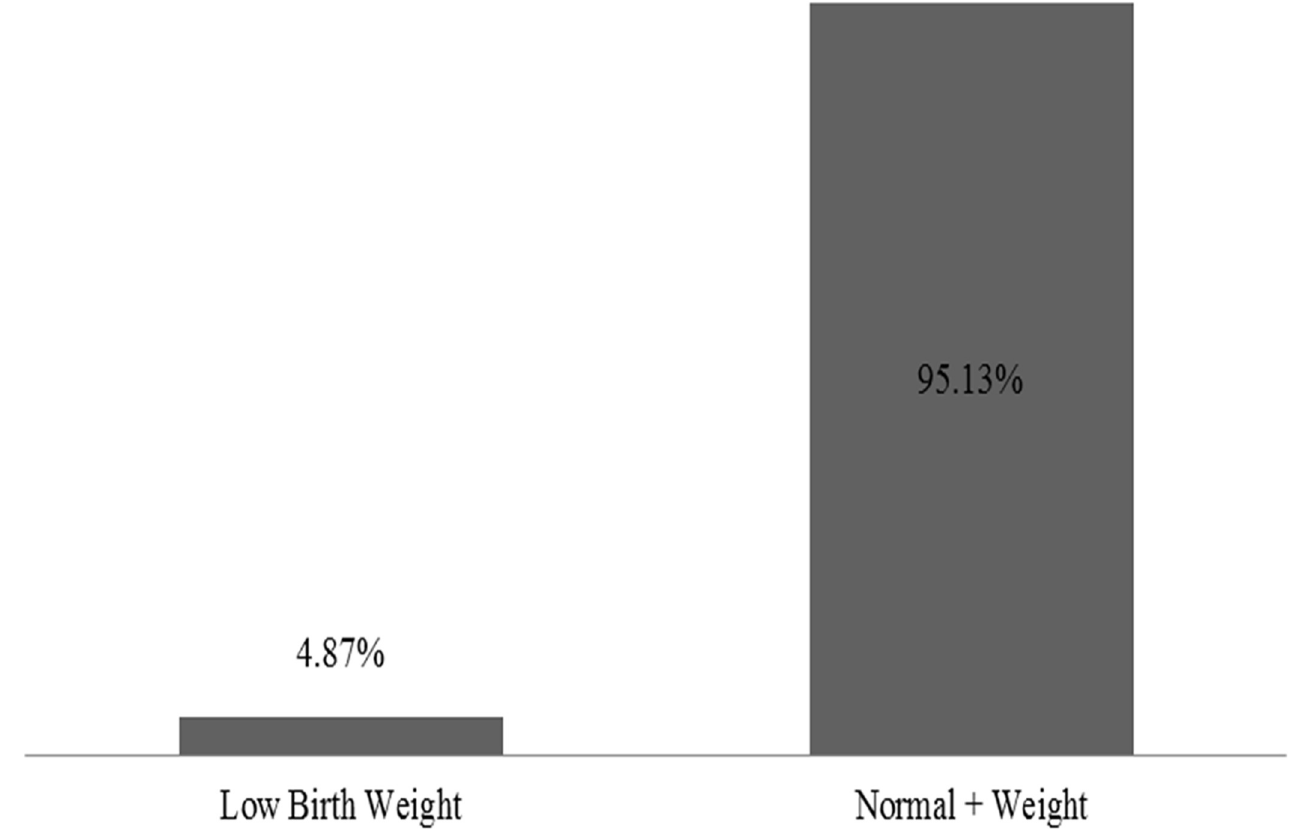
Fig 2. Percentage of South African U-5 children born at low and normal (and above) birth weights.